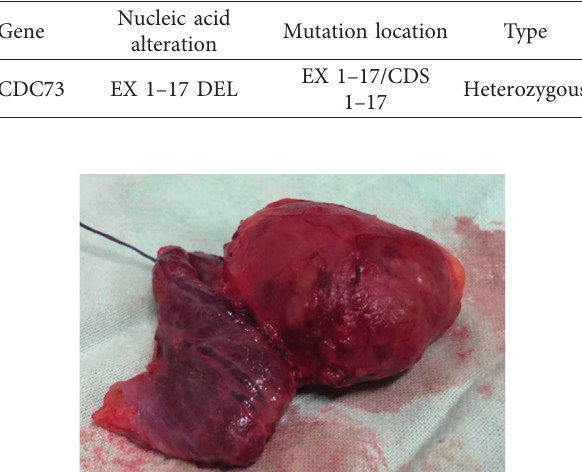
Figure 3: Macroscopic appearance of the excised parathyroid mass with